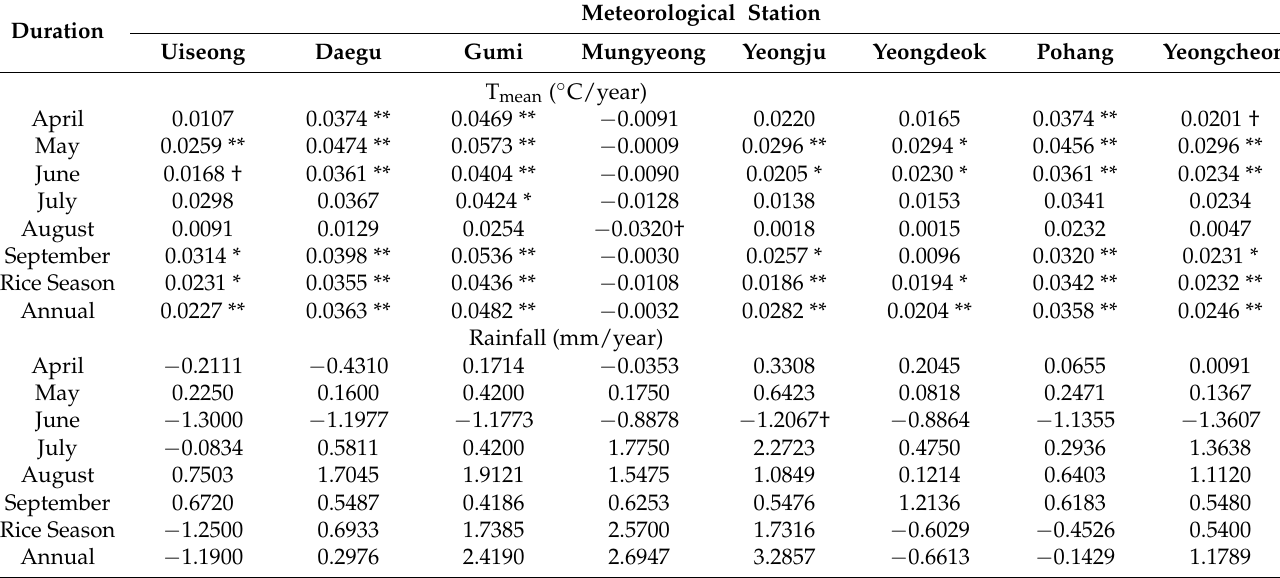
Table 5. Sen’s slope of monthly, seasonal and annual mean temperature (T mean ) and cumulative rainfall (P) during